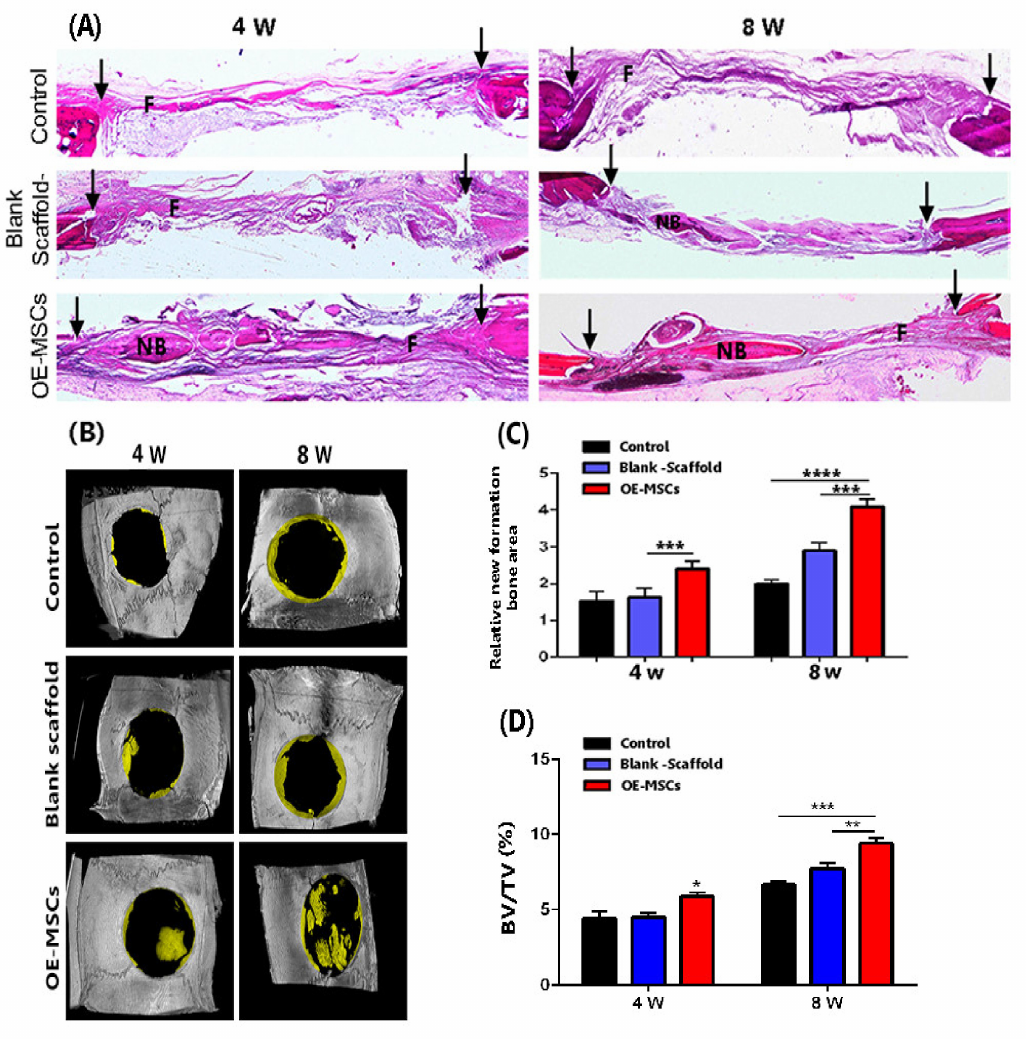
Figure 8. ( A ) After 4 and 8 weeks of implantation, H&E staining images showed new bone development in the calvarial defect area; ( B ) Representative micro-CT images of rat calvarial defects treated with or without OE-MSCs after 4 and 8 weeks; ( C ) The relative areas of fresh bone formation in three experimental groups, as determined by histological examination, ( n = 5, * p < 0.05; ** p < 0.01; *** p < 0.001; **** p < 0.0001). Human OE-MSCs encapsulated in 7 mg/mL collagen hydrogel regenerate calvarial bone in vivo; ( D ) In rat calvarial defect models, summarized data showing new bone tissue volume/total defect volume (BV/TV) for newly developed bone